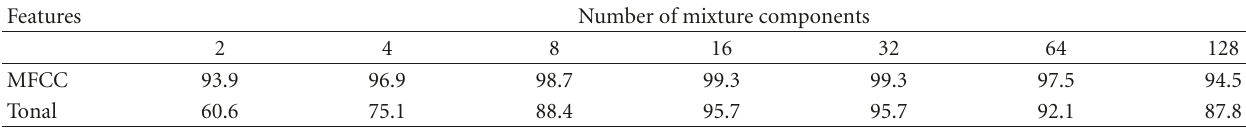
Table 1: Bird syllable recognition accuracy on clean data obtained by the standard model having various number of mixture components and employing the MFCC and tonal-based features.